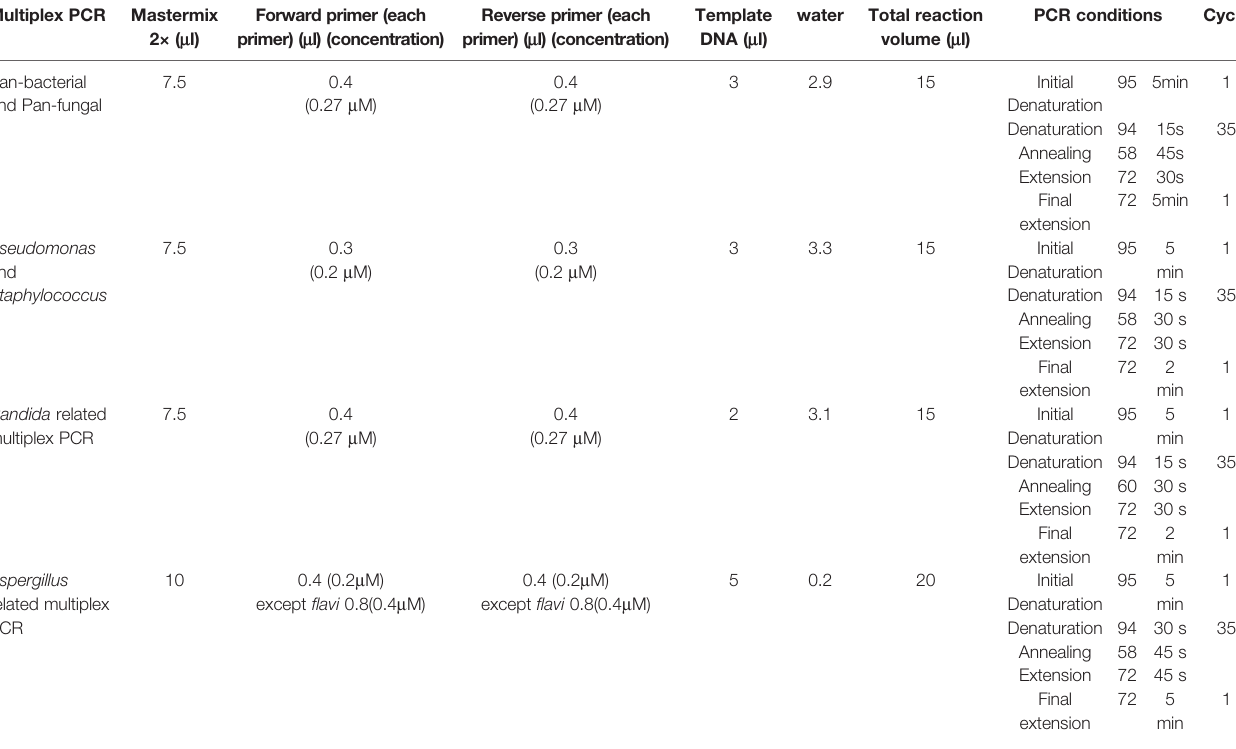
TABLE 2 | The optimized volumes and annealing temperature for each multiplex